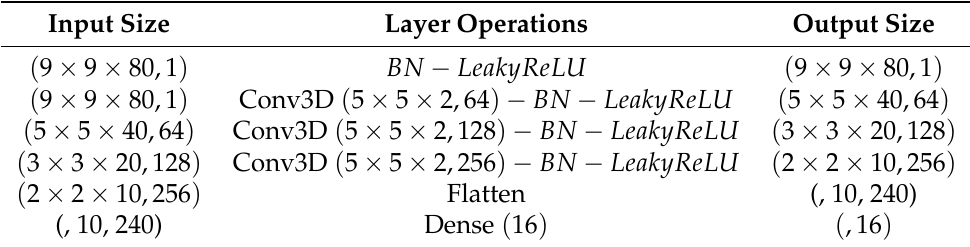
Table 5. The implementation details in